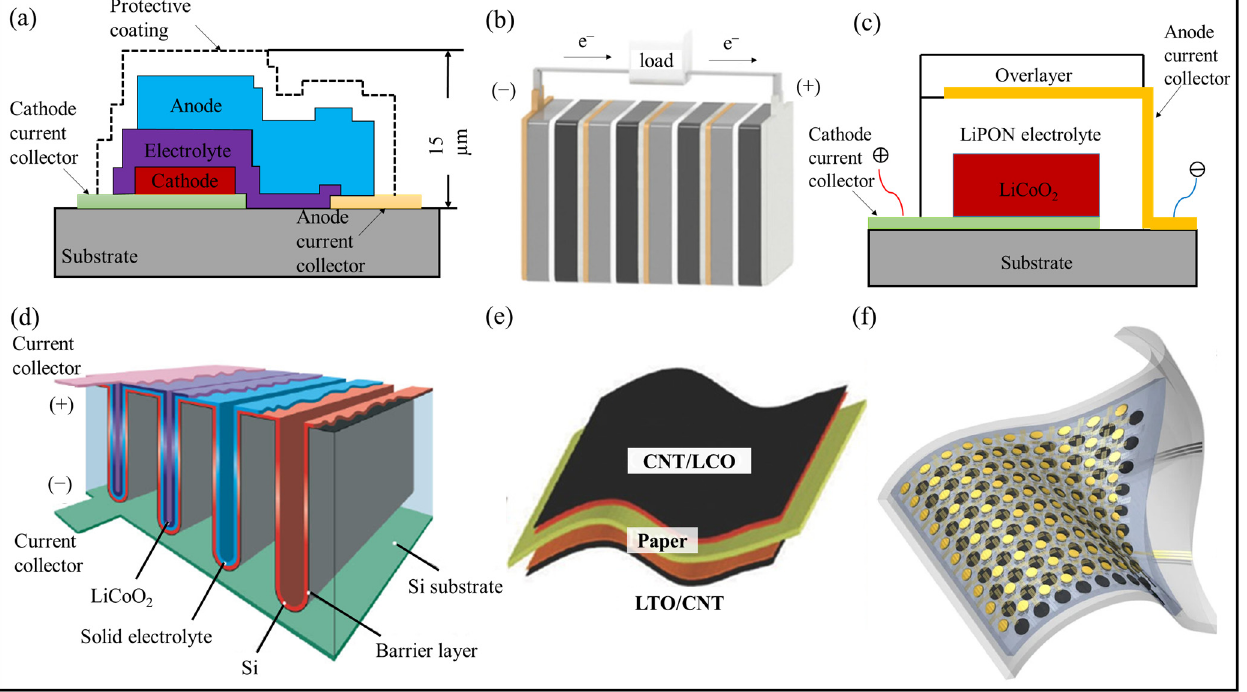
Figure 8. Scheme of di ff erent ba tt eries architectures. ( a ) Planar TFLIBs; ( b ) Bipolar LIBs [293]; ( c ) Anode-free TFLIBs; ( d ) 3D TFLIBs [112]; ( e ) Flexible and ( f ) stretchable LIBs [294].